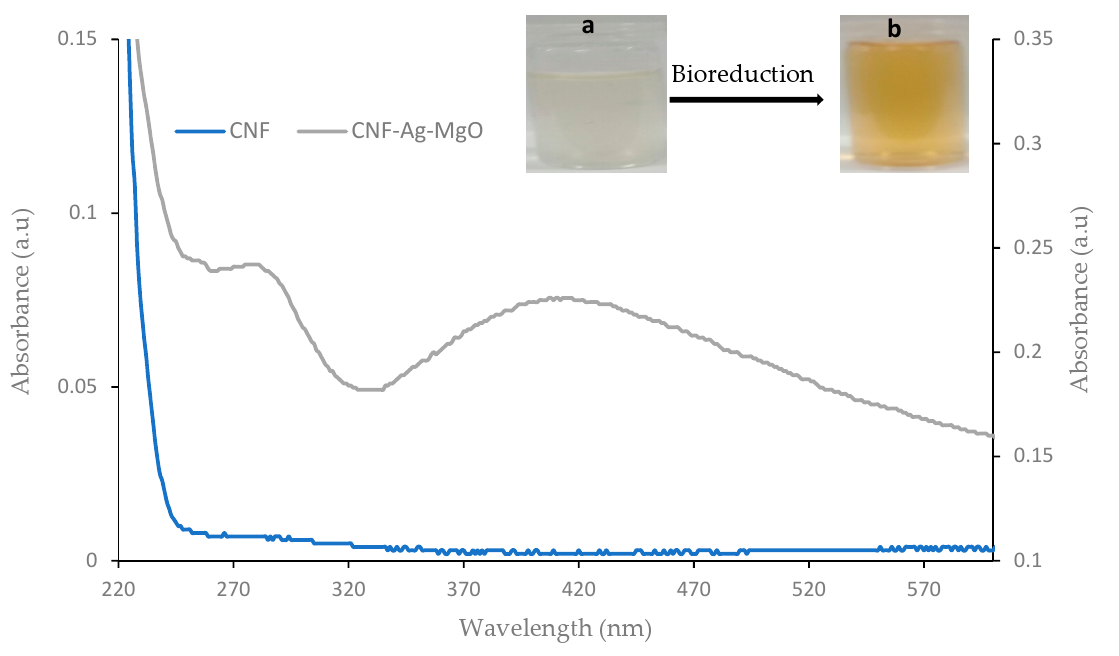
Figure 1. UV–Vis spectrum of CNF-AgMgO synthesized using C. paradisi peel extracts as a reducing agent at 40 ± 2 °C.